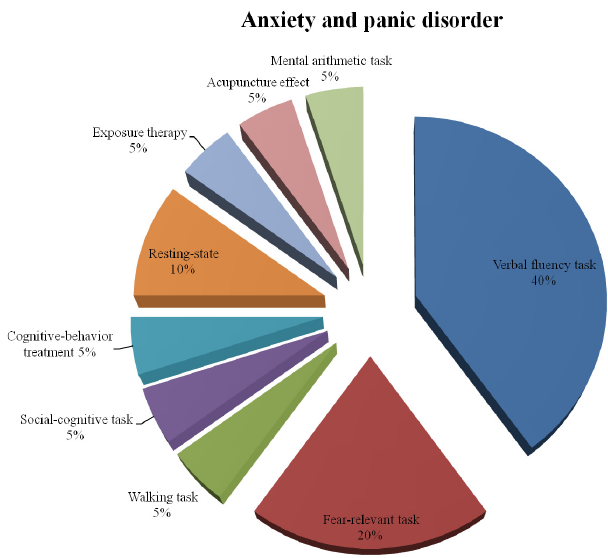
Fig. 5. Task-based distribution of studies on anxiety/fear and panic disorders (total studies: